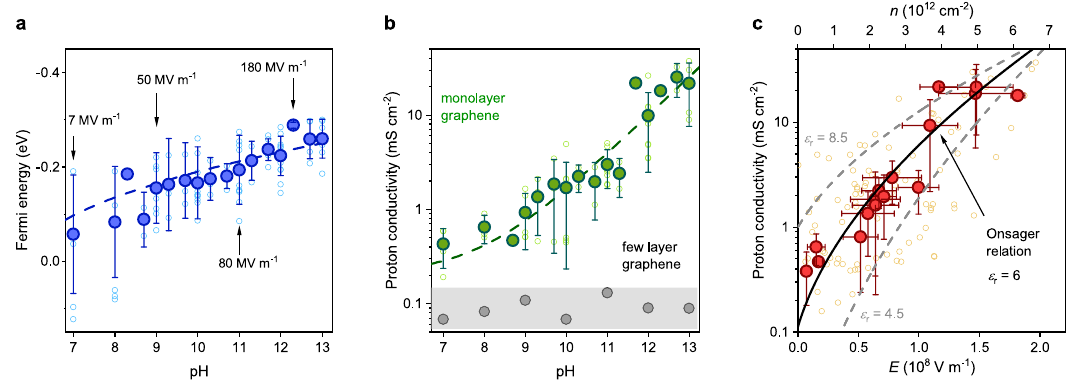
Fig. 2 | Wien effect in interfacial water dissociation. a Fermi energy μ e at zero- current conditions as a function of pH. Dotted curve, guide to the eye. The arrows show the inferred electric fi eld E using the analysis from c for the corresponding data points. b Proton conductivity, G H , of graphene devices measured simulta- neously with μ e in a (green symbols). Dotted curve, guide to the eye. Grey data points were obtained from few-layer graphene devices. The shaded area indicates